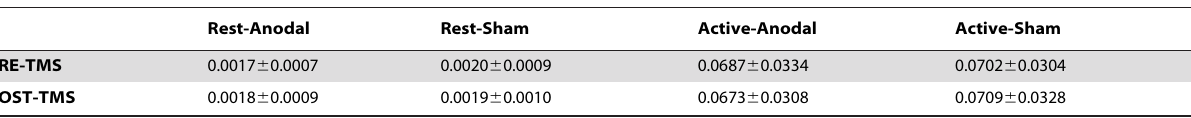
Table 2. Background EMG